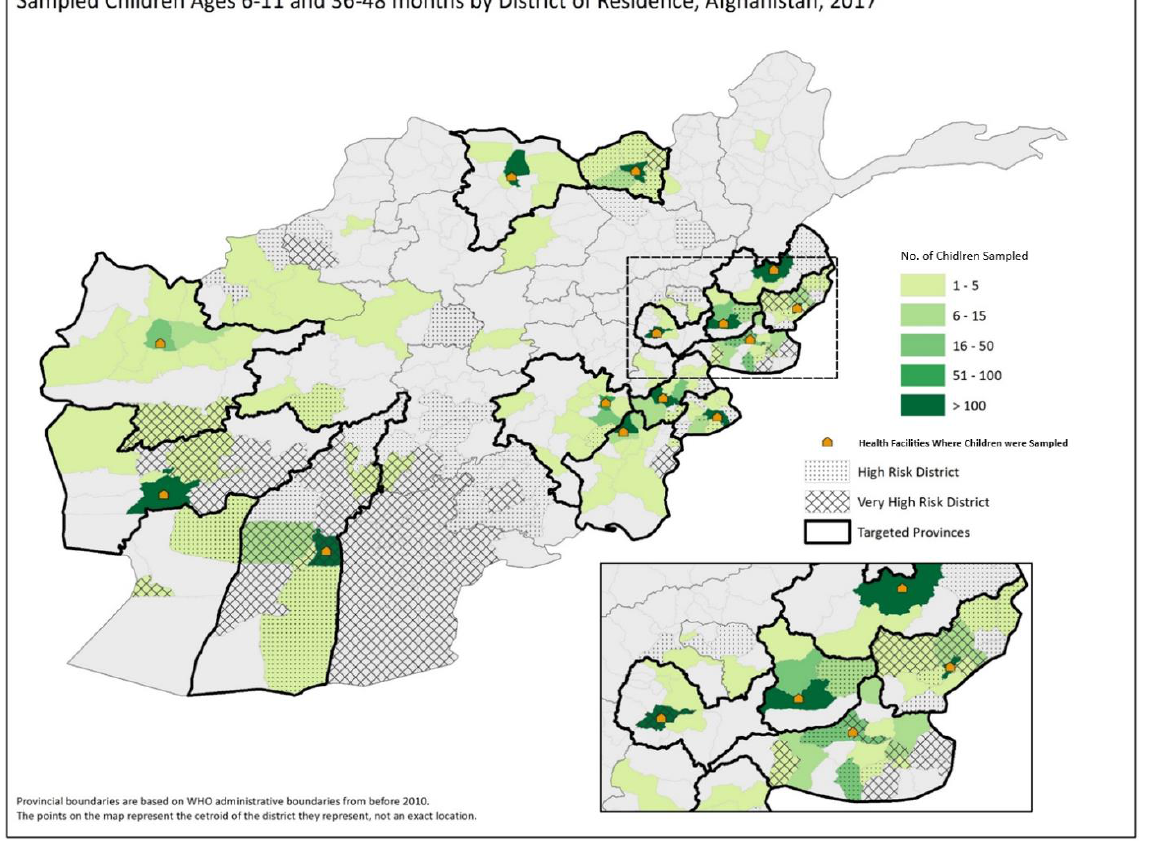
Figure 1. Provinces included in the serosurvey, Afghanistan, 2017. The map call-out shows details of the eastern region of Afghanistan for ease of viewing. Table 2. Health facilities in targeted provinces .